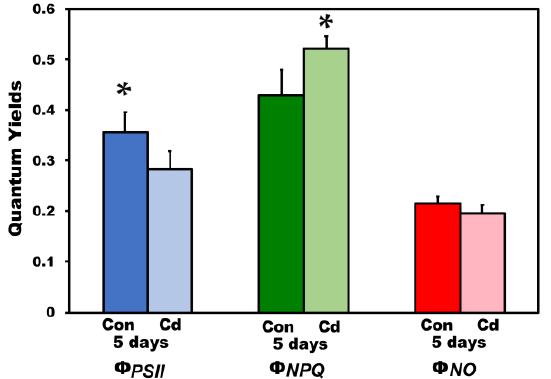
Figure 7. The quantum yields of PSII photochemistry (Φ PSΙΙ ), the regulated heat dissipation (Φ NPQ ), and the non-regulated energy dissipation (Φ NO ), measured at 900 μmol photons m −2 s –1 ; of control (con) and 5 days Cd-treated Salvia sclarea plants. Error bars are standard deviations ( n = 6). Means between the two treatments that are statistically different ( p < 0.05) are marked by an asterisk (*).